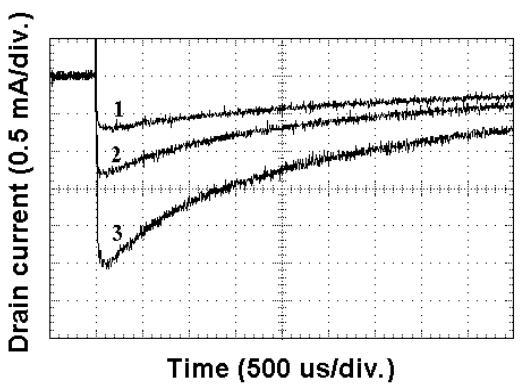
Fig. 3. GaAs MESFET drain current response to ionizing gamma irradiation at different gate bias